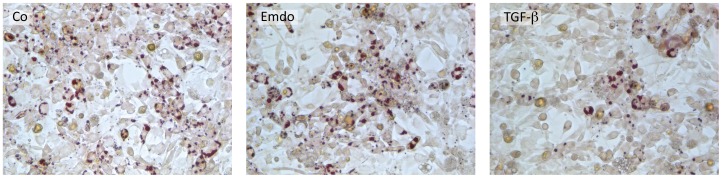
3T3-L1 cells retain their adipogenic potential after transient exposure to Emdogain®.The 3T3-L1 murine preadipocytes were incubated for one day with growth medium containing Emdogain® (100 µg/ml) or TGF-β (10 ng/ml). Then the medium was replaced by basal adipogenesis-inducing medium containing rosiglitazone and indomethacin for 5 days and lipid staining was performed.